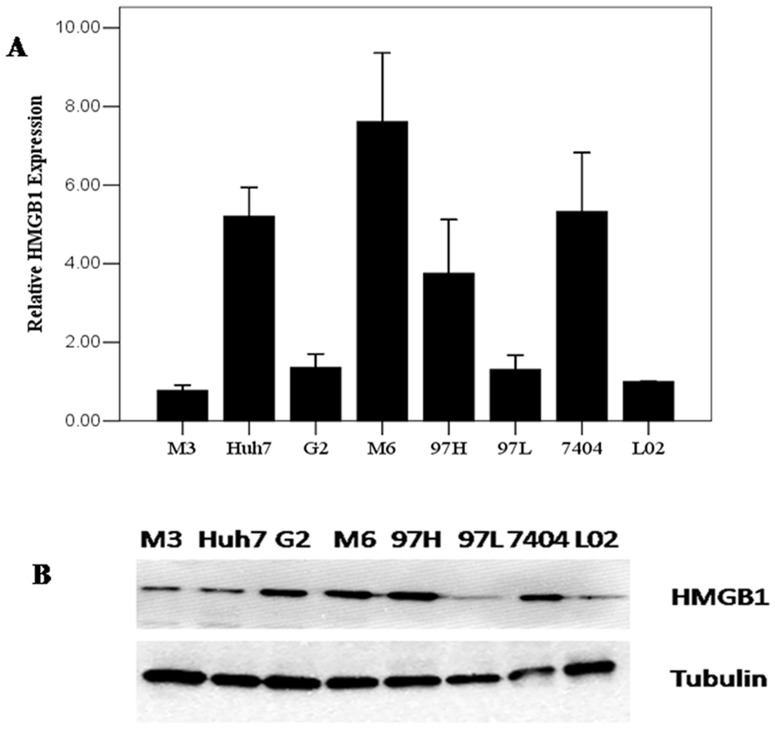
Expression analysis of HMGB1 mRNA and protein in normal hepatocyte line (L02) and HCC cell lines (HCCLM3, Huh7, HepG2, HCCLM6, MHCC97H, MHCC97L, BEL-7404) by real-time PCR (A) and Western blotting (B).